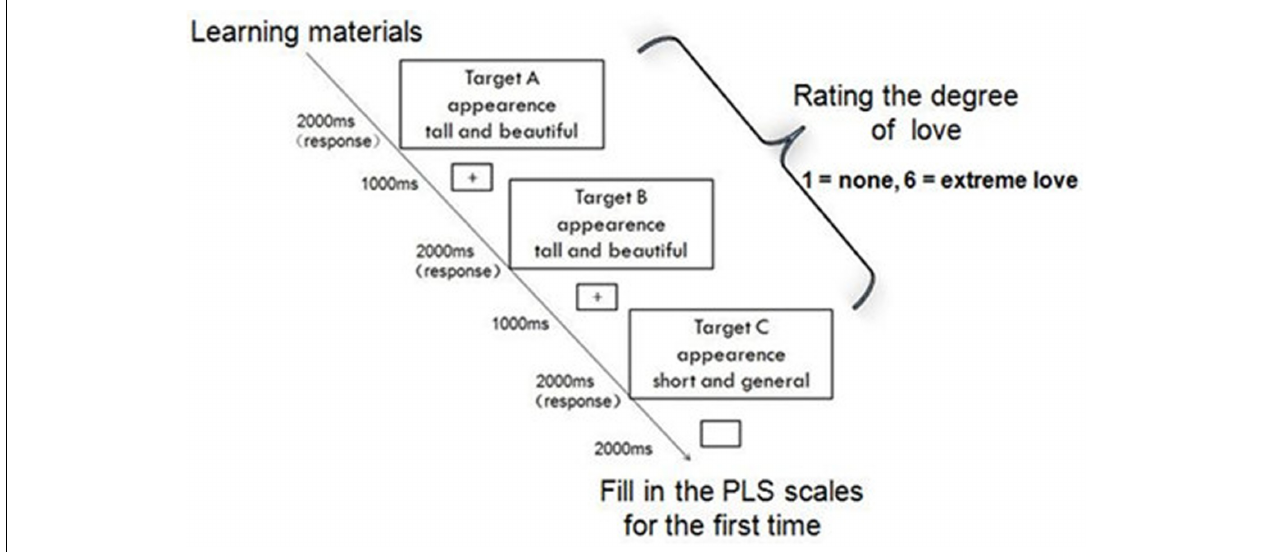
FIGURE 1 | Part 1 consisted of three phases: studying the materials, rating on the computer, and completing the PLS. This figure presents a schematic depiction of the stimuli and rating task design of Part 1 ( love ). First, a fixation cross hair was presented for 1000 ms followed by the experimental stimuli (Lover A, Lover B, and Lover C) that were displayed for 2000 ms or until response. The top line in each stimuli-containing rectangle indicated a target person, the middle line indicated the domain of comparison (excellence and similarity), and the bottom line indicated the specific traits in these two domains.